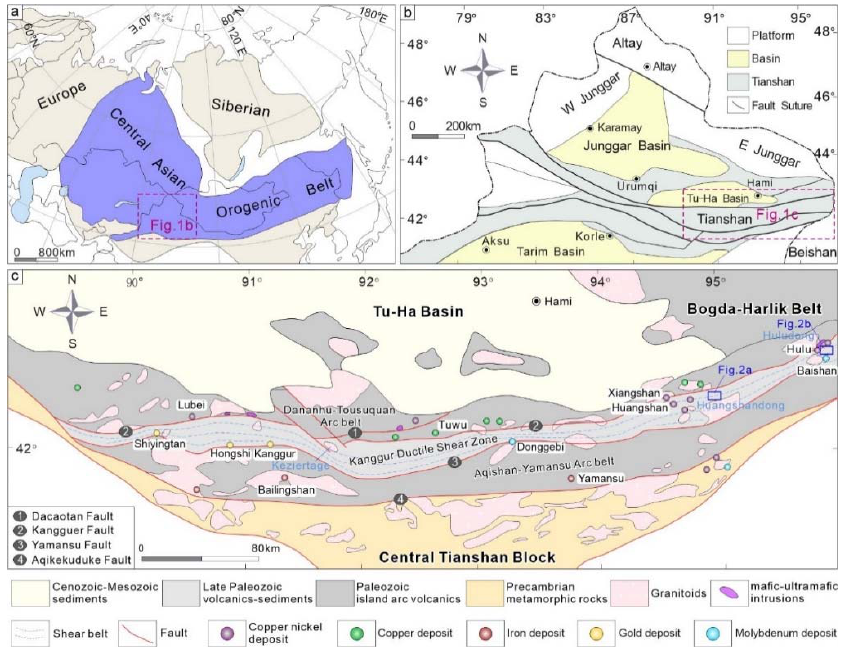
Figure 1. ( a ) Simplified map of the CAOB. ( b ) Tectonic framework in northern Xinjiang. ( c ) Simplified geological map of eastern Tianshan showing the distribution of representative deposits, modified from Li et al.